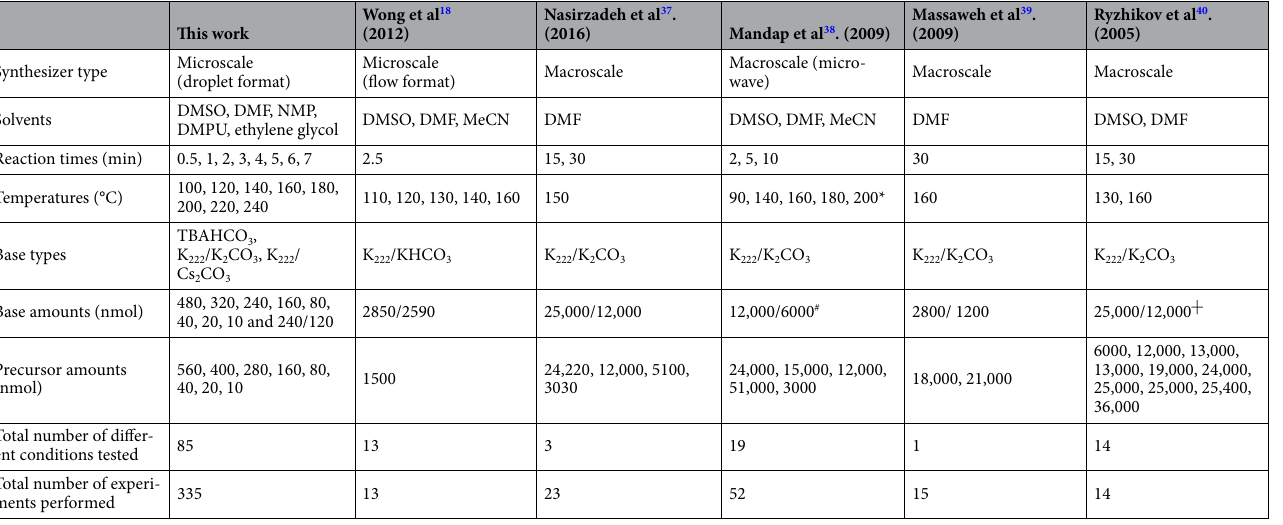
Table 1. Summary of parameters and conditions tested in reports of optimization of [ 18 F]Flumazenil using nitromazenil as precursor in microscale and macroscale platforms. # Not reported but the amount of K 222 was computed based on the amount of precursor and an indicated precursor to K 222 /K 2 CO 3 molar ratio of 0.5:1. Ratio of K 222 to K 2 CO 3 needed to calculate K 2 CO 3 was inferred from a paper they referenced 72 . ┼ Based on 1:1 precursor to K 222 /K 2 CO 3 molar ratio. Note: different volumes of solvent were used as an additional parameter (0.5, 1.0, 1.5, and 2.0 mL). *In the microwave reactor, the pressure was also varied (0, 100, and 200